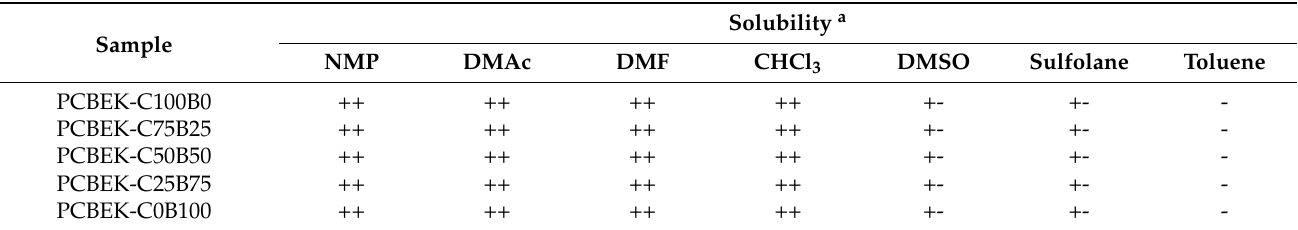
Table 5. Solubility of copolymer PCBEKs in different organic solvents.